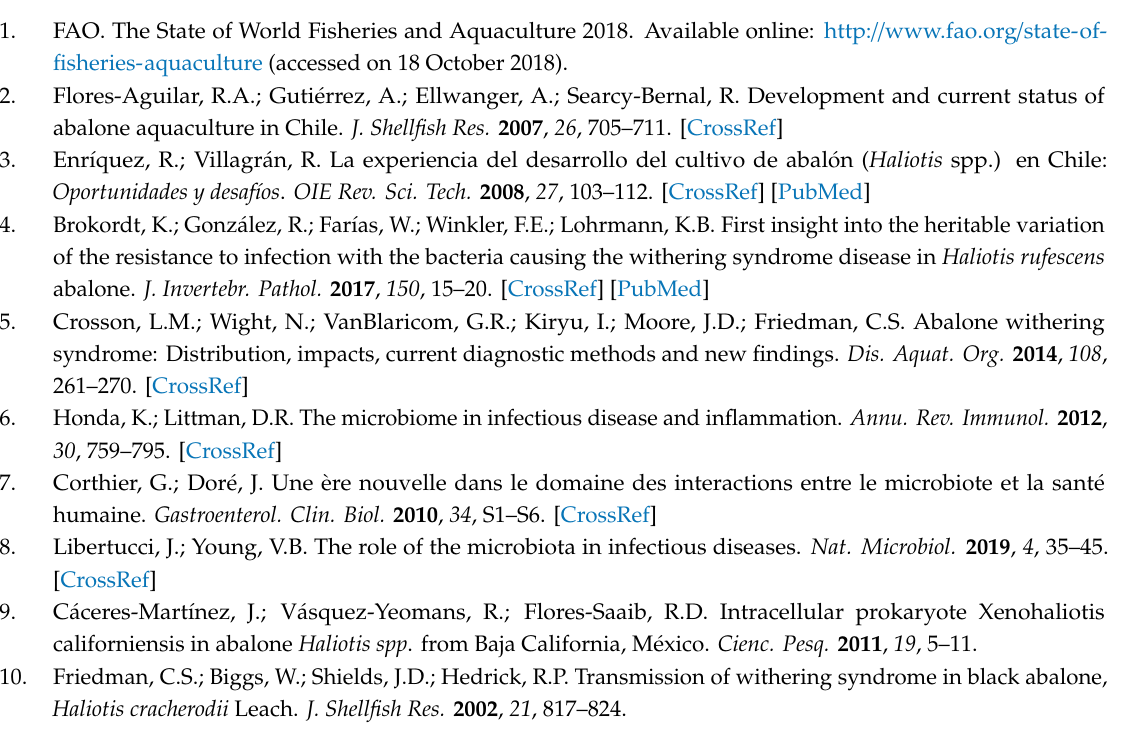
Figure S1: Macroscopic and histologic images of healthy and WS-a ff ected abalones. Table S1: Reads obtained from healthy and disease specimens from Illumina